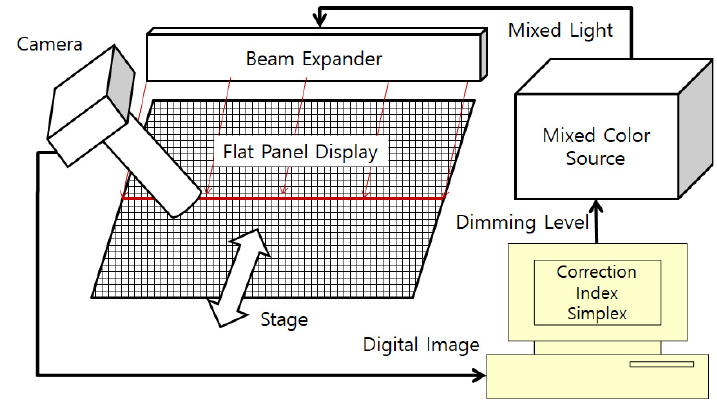
Figure 1. Conceptual diagram of an an automatic optical inspection (AOI) system using a mixed color